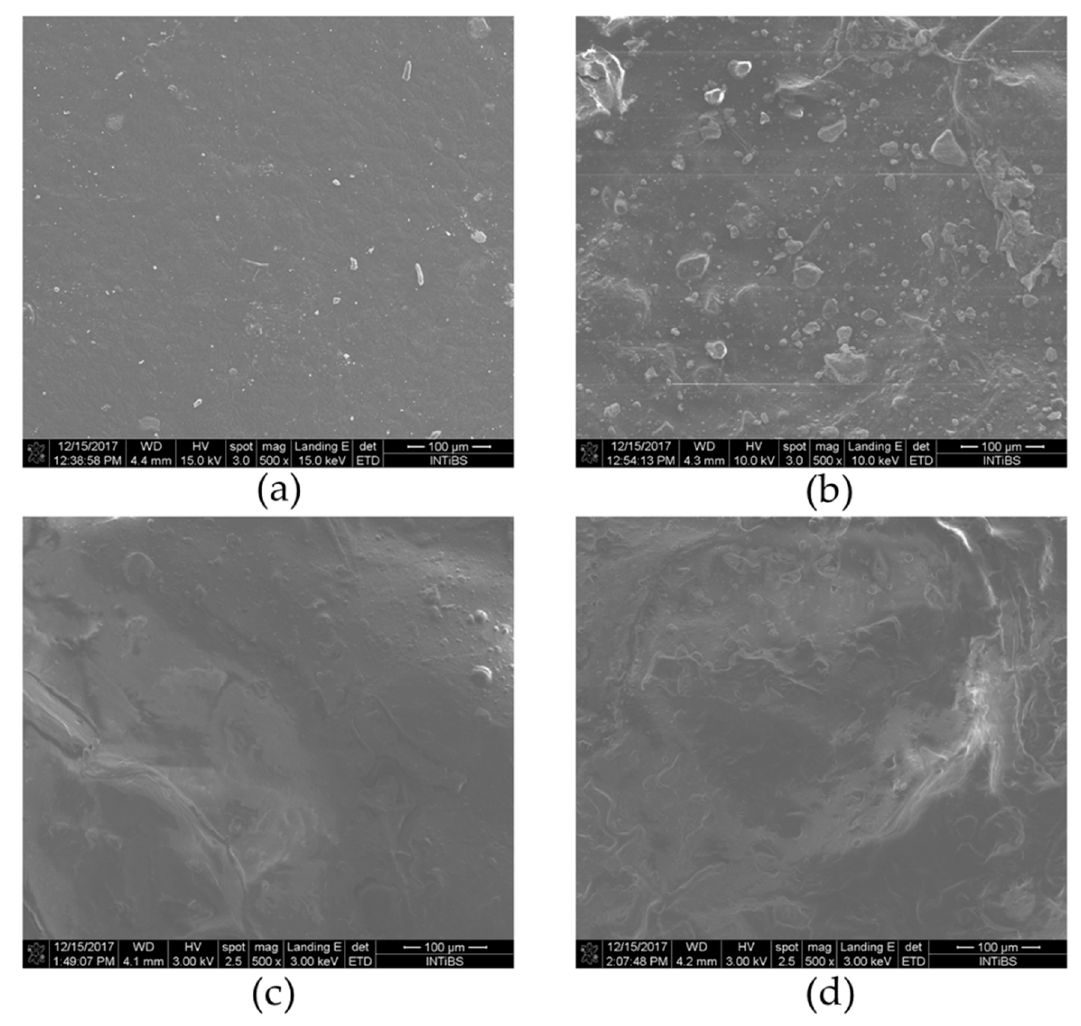
Figure 7. SEM of ( a ) galactose hydrogel, ( b ) 0.1 resveratrol/nHAp/hydrogel, ( c ) 0.5 resveratrol/nHAp/hydrogel, and ( d ) 1.0 resveratrol/nHAp/hydrogel. Magnification 500×.